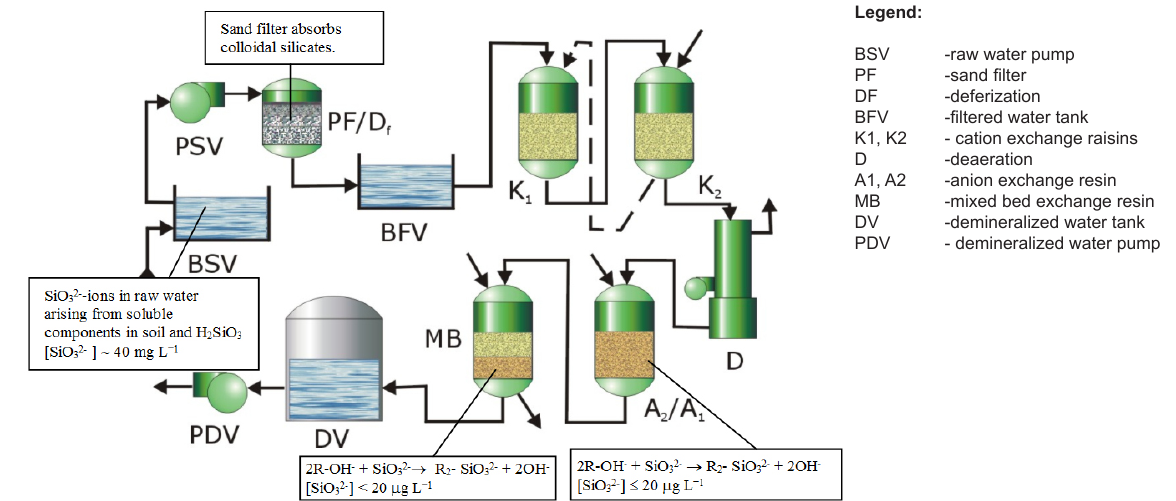
Figure 1. Water purification line in the TPP Nikola Tesla, removal of silicon from raw